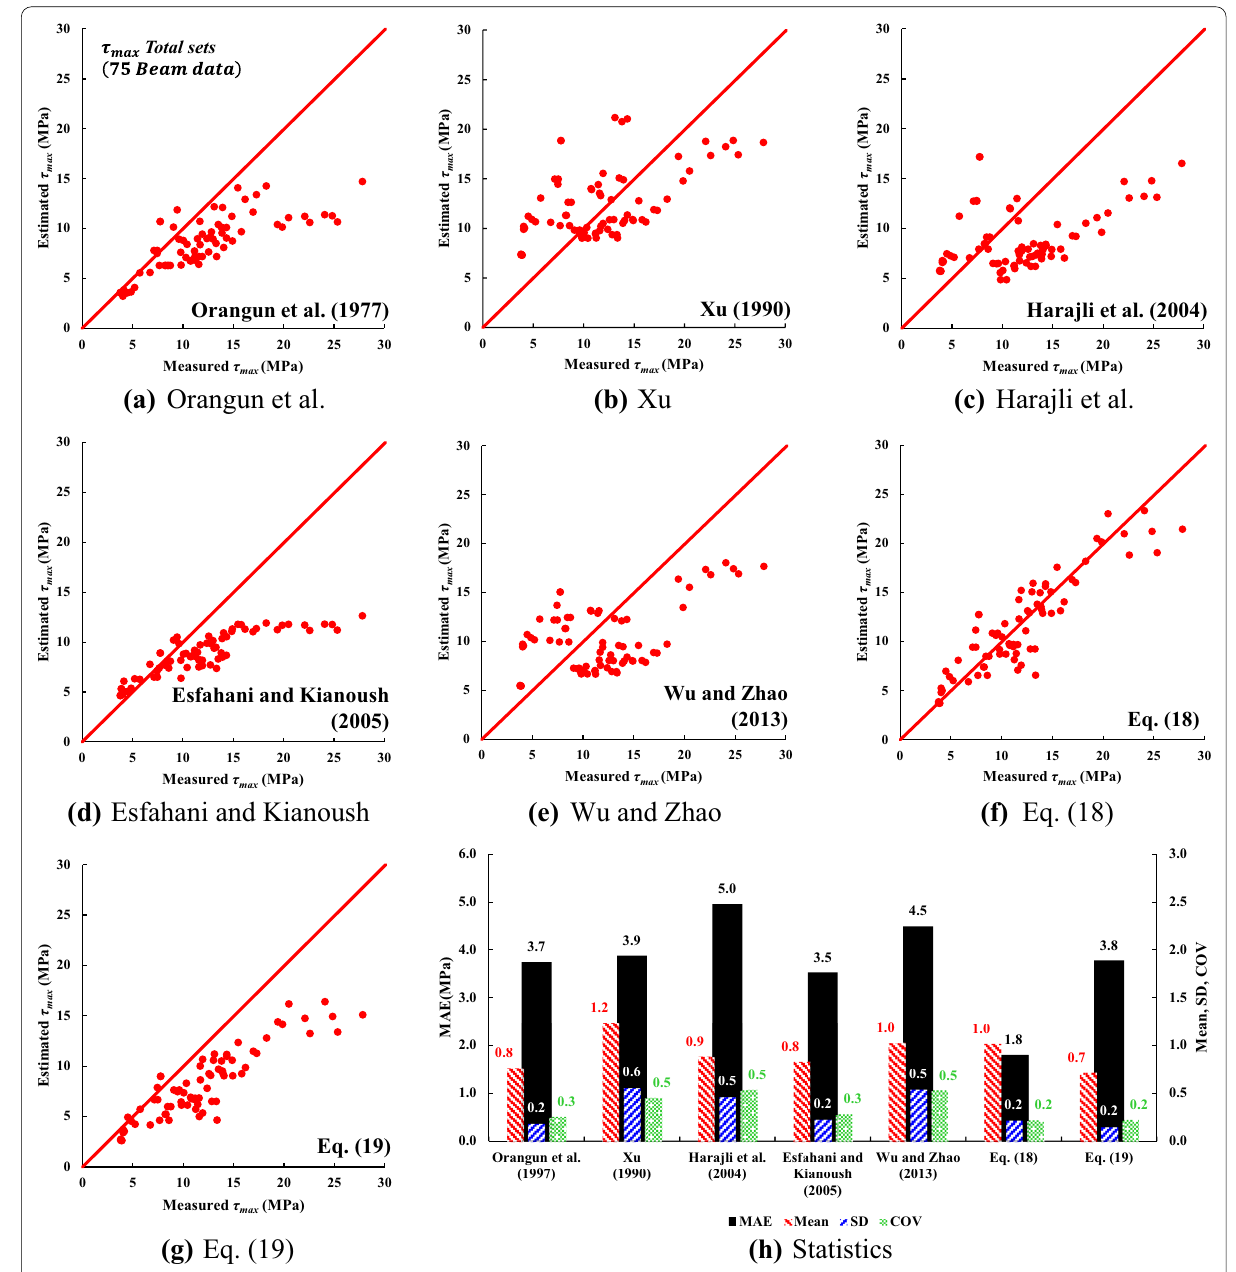
Fig. 14 Accuracy comparison for τ max of beam